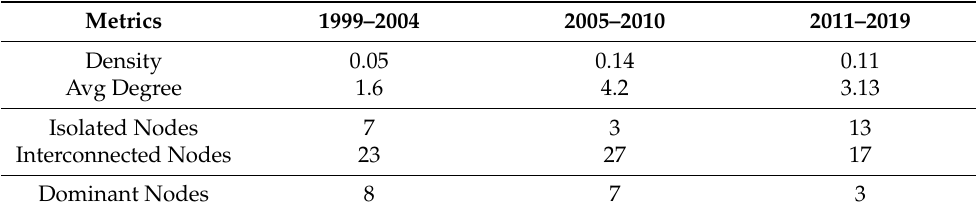
Table 6. Network metrics for 0.8 threshold level on the External Balance on Goods and Services (% of GDP)